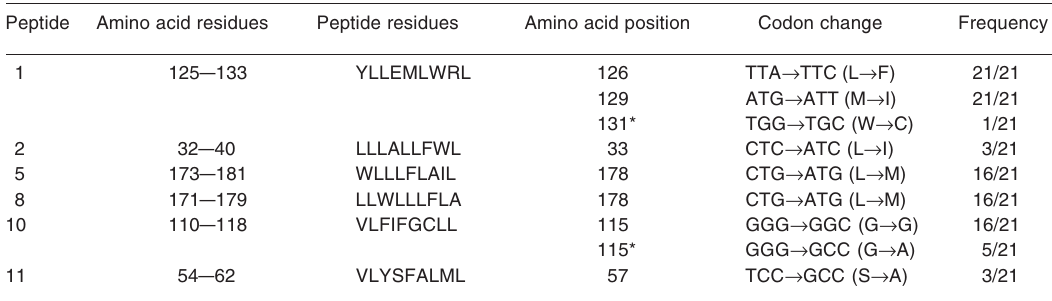
Table 2. Sequence variation in the HLA-A2-restricted peptides of latent membrane protein 1 (LMP1) from patients with nasopharyngeal